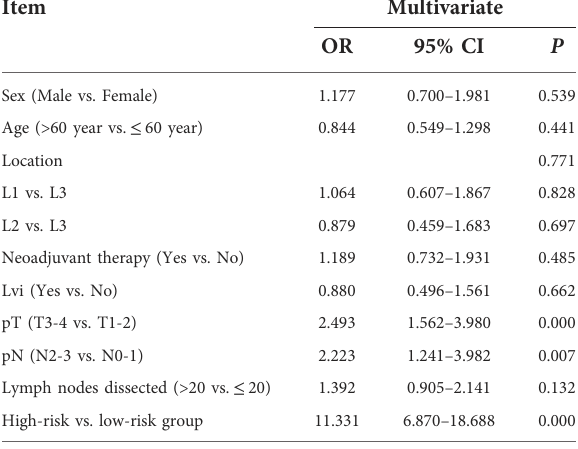
TABLE 1 Multivariate COX regression overall survival